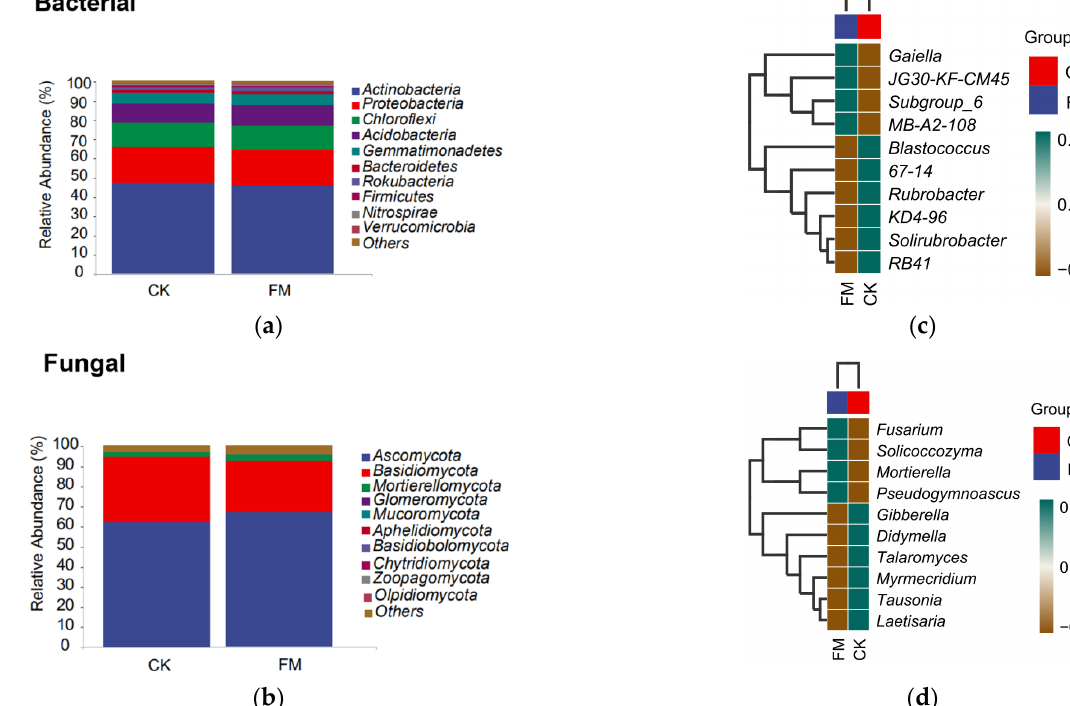
Figure 4. The relative abundance of dominant bacteria ( a ) and fungi ( b ) at the level of the phylum; the abscissa is the name of each sample, and the ordinate is the relative abundance of each dominant group at the phylum level (top 10). Heat map of species composition of bacterial ( c ) and fungal ( d ) communities; the samples were clustered by UPGMA according to the Pearson correlation coefficient matrix, and arranged according to the clustering results. The abundance data of the top 10 genera of average abundance were used to draw the heat map.